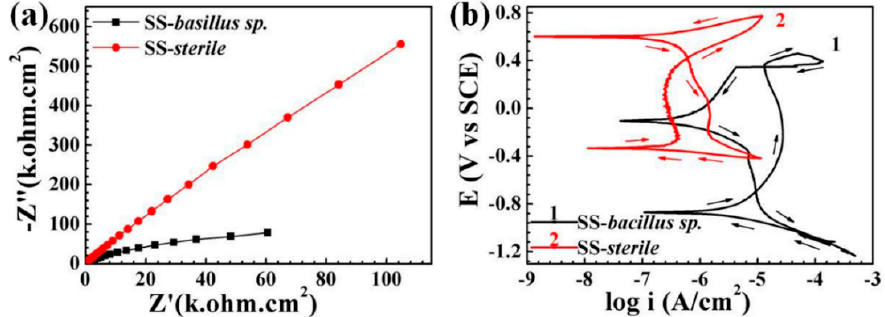
Figure 4. ( a ) Nyquist plots and ( b ) potentiodynamic polarization curves of the steel samples tested in the ASW with ( Bacillus sp. ) and without (sterile) the bacteria after 90 days of exposure. SS: the steel plates.